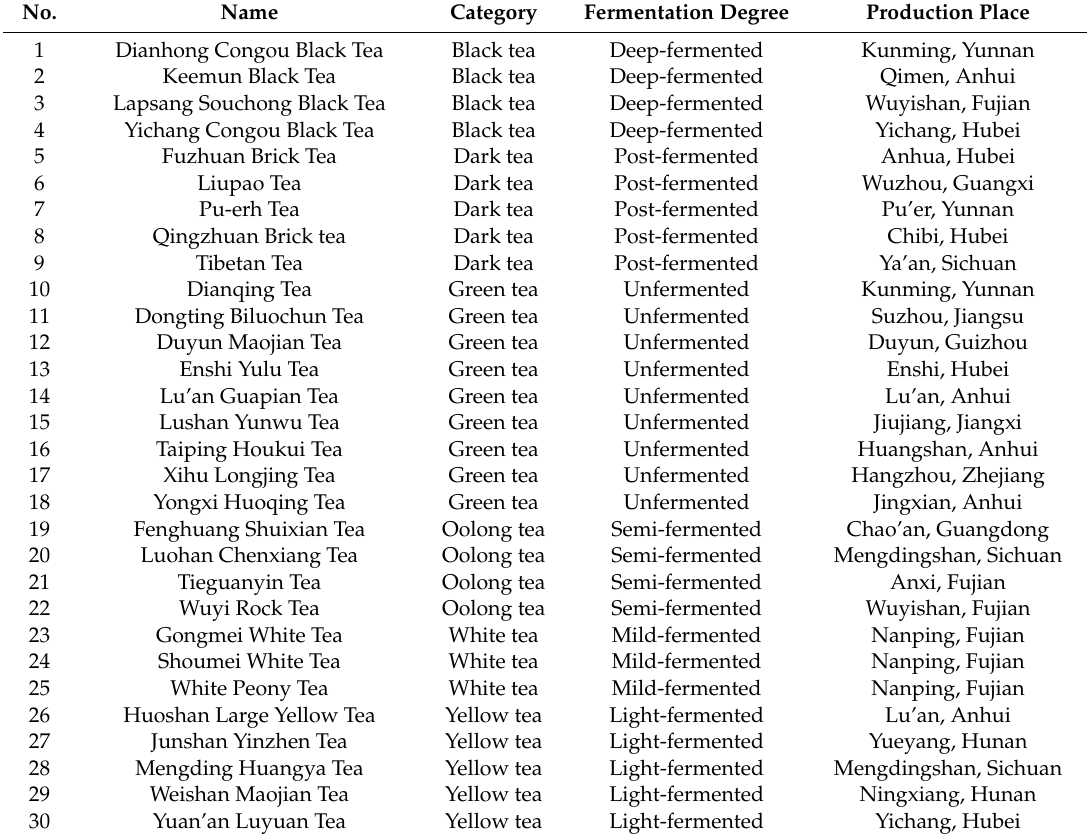
Table 1. Basic information about the 30 Chinese